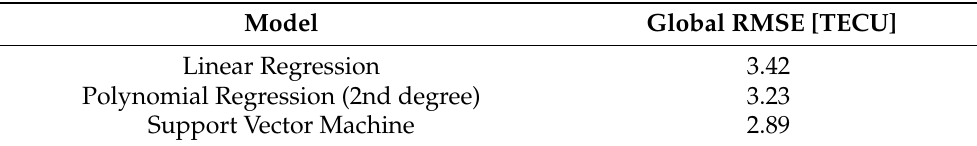
Table 1. Global RMSE for each